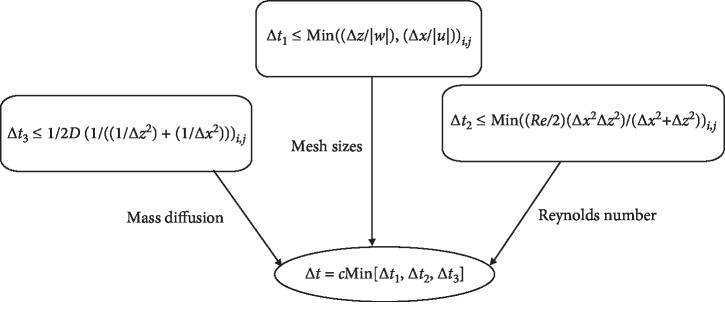
Schematic diagram for stability to obtain Δt.